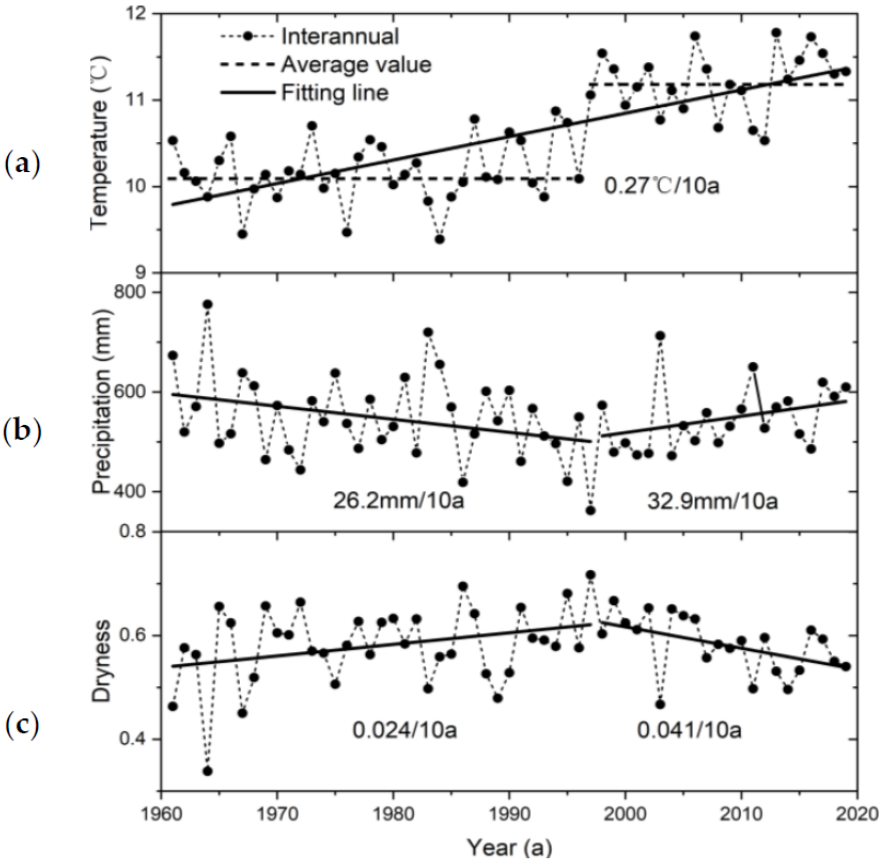
Figure 3. Variation curve of ( a ) temperature, ( b ) precipitation, and ( c ) aridity index from 1961 to 2019. Precipitation increases enhance humid climates, and temperature increases often cause dry climates by accelerating potential evaporation. An aridity index change curve was plotted in Figure 3c to clarify the dry–wet changes under the combined effects of precipita- tion and temperature. The fitting curve of precipitation and dryness was symmetrical near the horizontal axis. The dry-to-wet climate transition occurring around 1997 indicates that the climate change in eastern Northwest China was dominated by precipitation, which might be related to the impact of the temperate climate zone. However, the sudden change in mean temperature is consistent with the sudden dry-to-wet transition. Thus, we speculate that the transition is related to the dominant effects of precipitation and temperature. Precipitation can cool the atmosphere through the land surface evaporation process, and the increased cloud cover decreases the solar radiation; of these, the latter has a more notable effect. Temperature affects atmospheric saturated water vapor pressure and large-scale circulation through atmospheric thermal processes and influences the local water cycle through land surface processes to